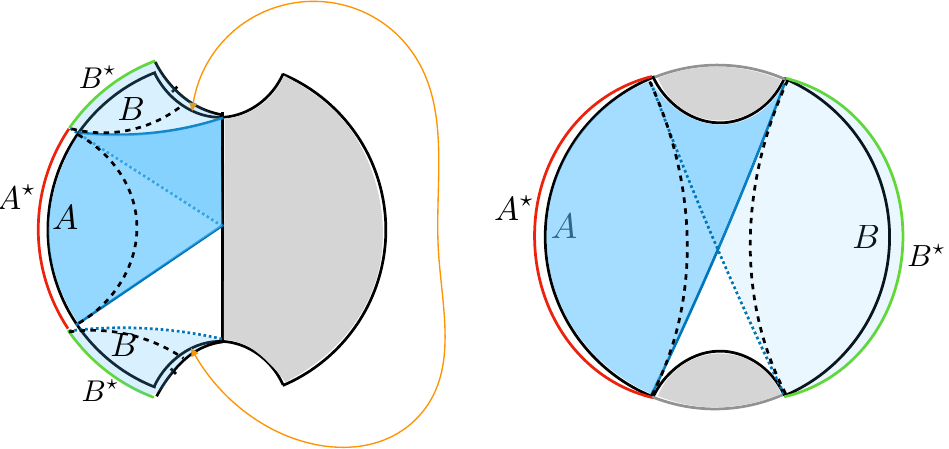
Figure 4 . These figures demonstrate the fact that I ( A, B ? ) = 0 . The left figure follows the representation of the thermofield double discussed in figure 2. The dominant configuration follows the black dashed curves, while the blue curves (and associated homology region) has a larger area.